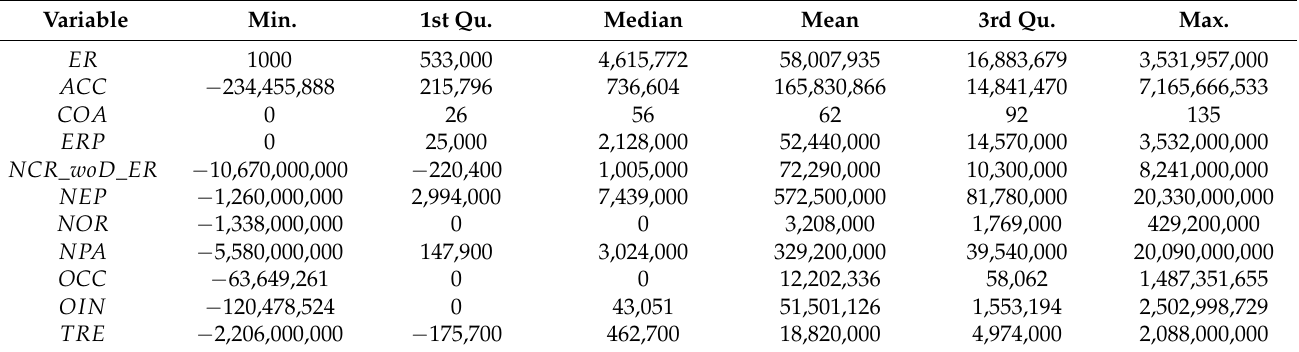
Table 5. Variable summary for reinsurance undertakings, observed in the years 1997 and